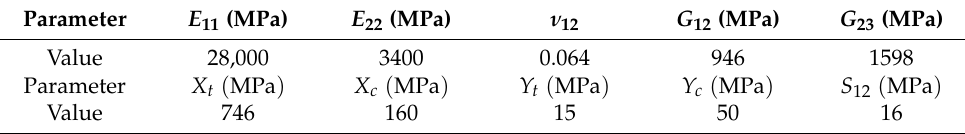
Table 2. The mechanical properties of GFRP